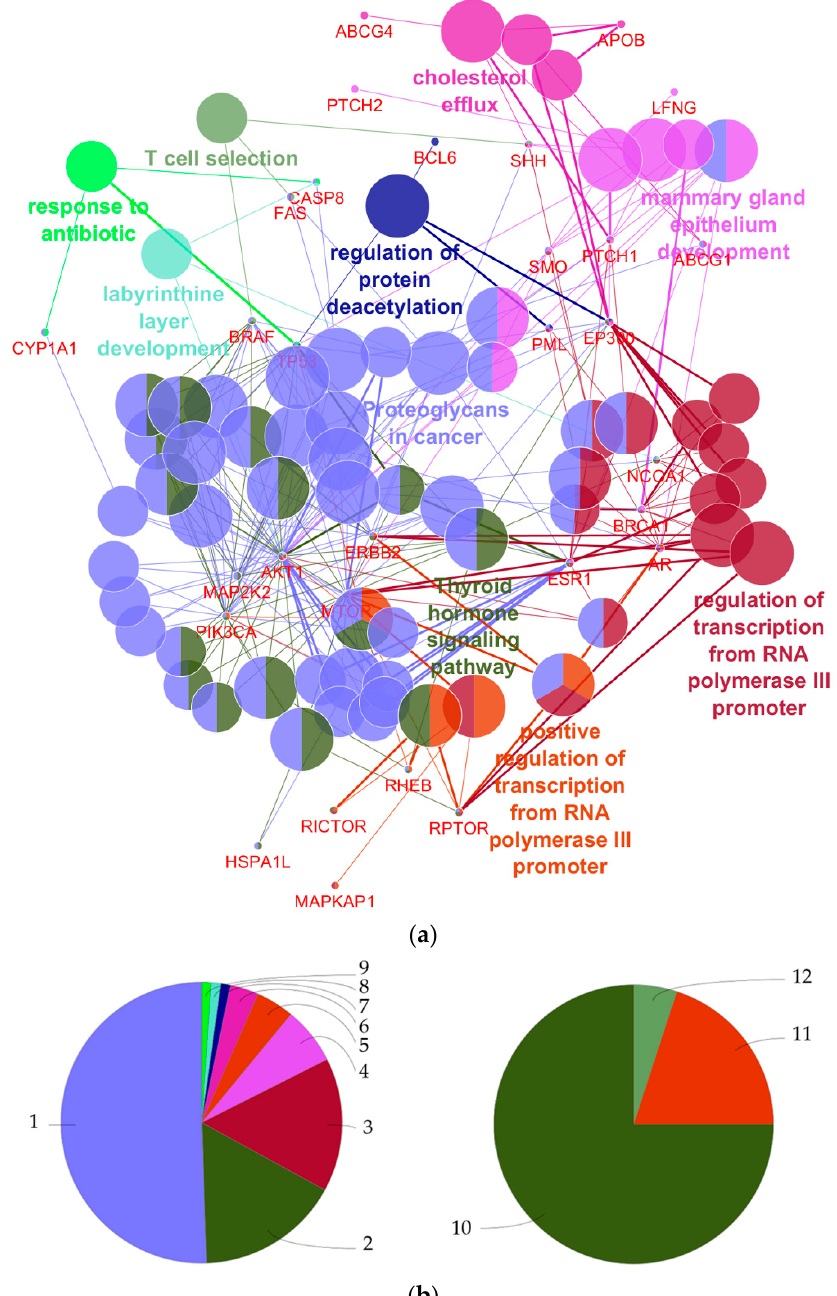
Figure 4. Results of visualizing functional annotations corresponding to the 47 genes using ClueGO: ( a ) Functionally grouped network with GO/KEGG terms as nodes linked based on kappa score level ≥ 0.4, where the label of the most significant term per group is shown only. The node size indicates the term enrichment significance; ( b ) Overview charts showing the proportion of each group associated with the 27 common genes (left side) and the 20 predicted genes (right side). 1—Proteoglycans in cancer; 2—Thyroid hormone signaling pathway; 3—Regulation of transcription from RNA polymerase III promoter; 4—Mammary gland epithelium development; 5—Positive regulation of transcription from RNA polymerase III promoter; 6—Cholesterol efflux; 7—Regulation of protein deacetylation; 8—Labyrinthine layer development; 9—Response to antibiotics; 10—Positive regulation of TOR signaling; 11—TOR complex; 12—T cell selection.